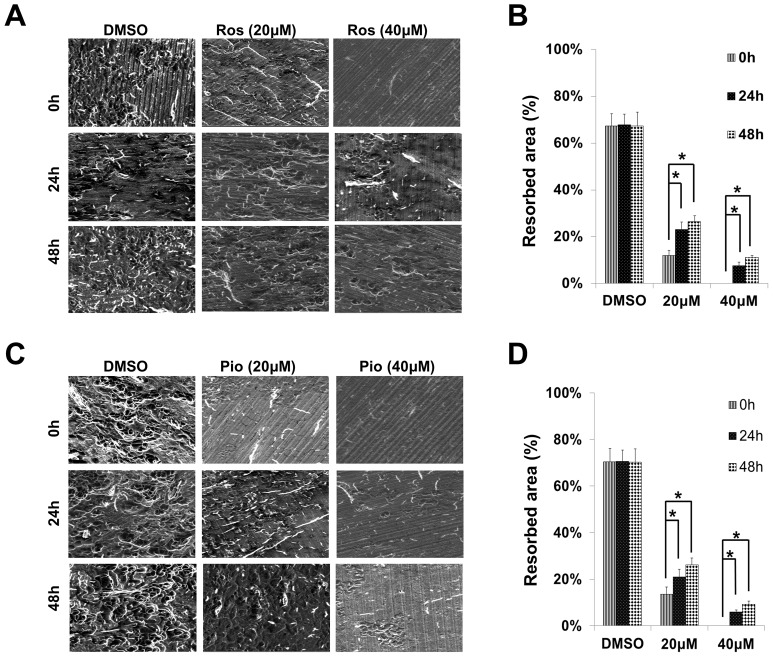
The inhibitory effects of rosiglitazone and pioglitazone on the formation of functional osteoclasts on bone slices are significantly decreased in RANKL-pretreated BMMs.(A) BMMs were seeded on bone slices and treated with M-CSF (44 ng/ml) and RNAKL (100 ng/ml) for 10 days. Vehicle (DMSO), 20 µM or 40 µM of rosiglitazone (Ros) was added at the beginning of the assays (0 hour – 0 h), or 24 h and 48 h after the start of the assays. Bone resorption pits were visualized by SEM and one representative view from each condition is shown. All assays were performed in duplicates and were repeated 2 times. (B) Quantification of bone resorption assays for rosiglitazone in A. 5 view areas on each bone slice were randomly chosen. Bars show mean percentage of resorbed bone area ±S.D. *P<0.05. (C) The same set of assays in A was performed with pioglitazone (Pio). (D) The bone resorption assays in C were quantified as described in B. *P<0.05.